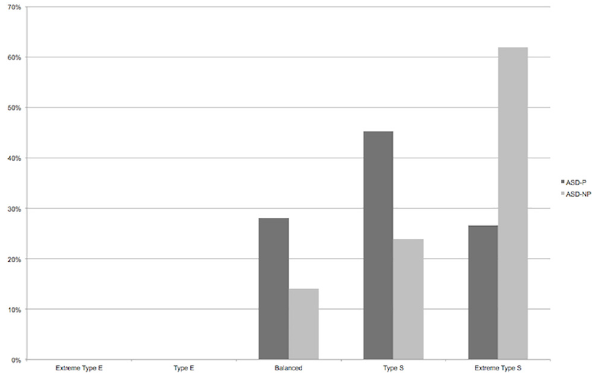
Fig 1. Differences in the distribution of categorical drives for empathizing/systemizing, by group (ASD-P vs ASD-NP).